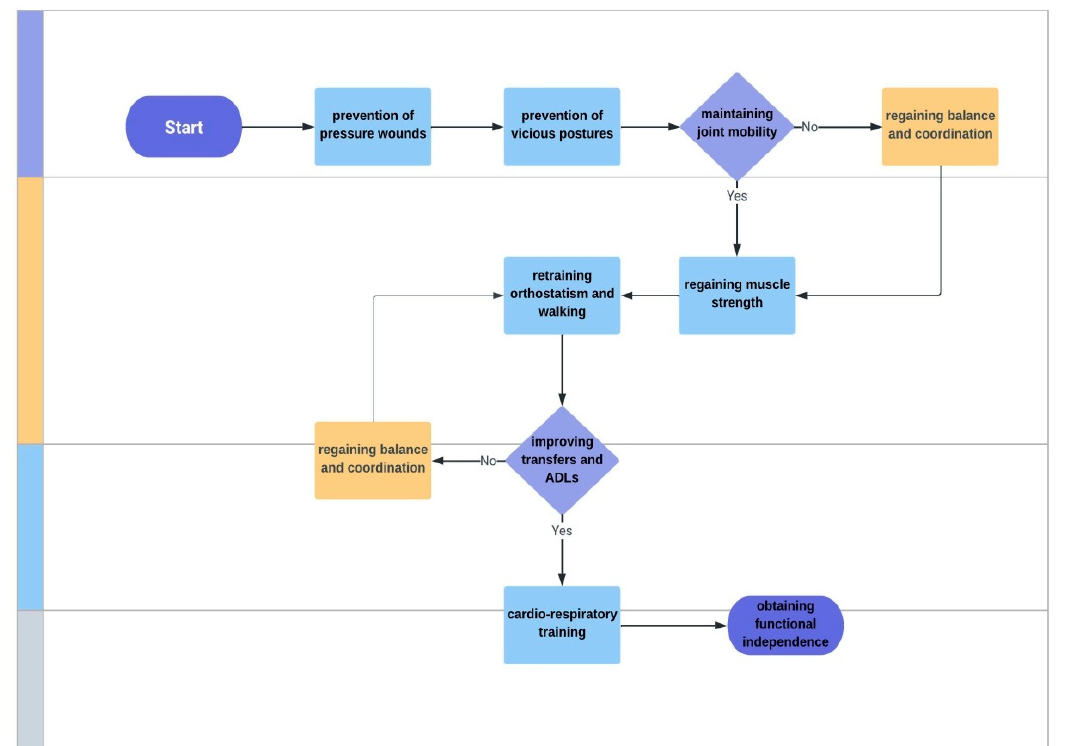
Figure 2. Main objectives of the rehabilitation program. ADLs—activities of daily living.